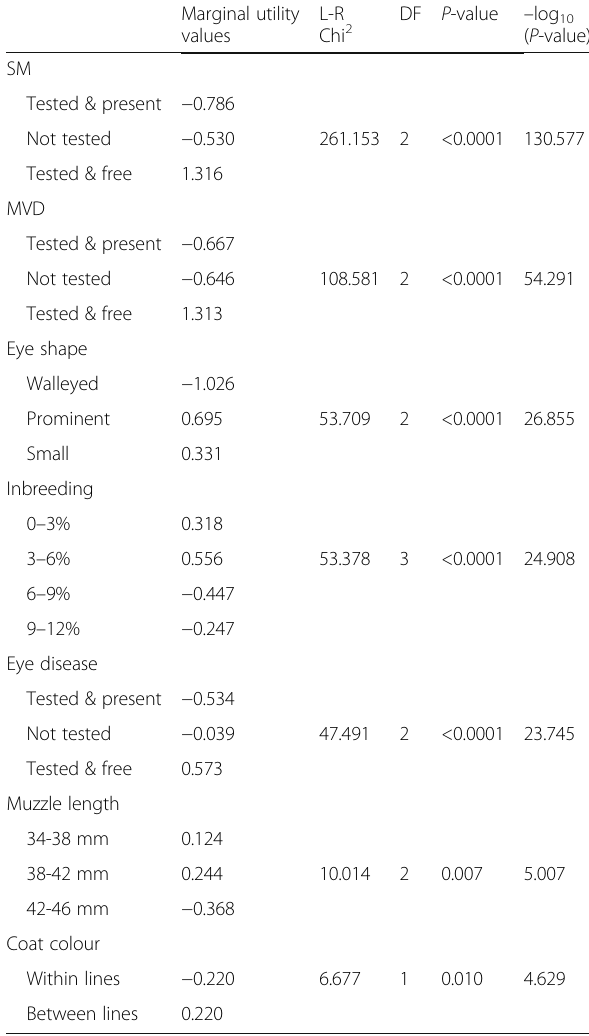
Table 4 Final multinomial logit model results for each trait. Traits sorted in decreasing order of